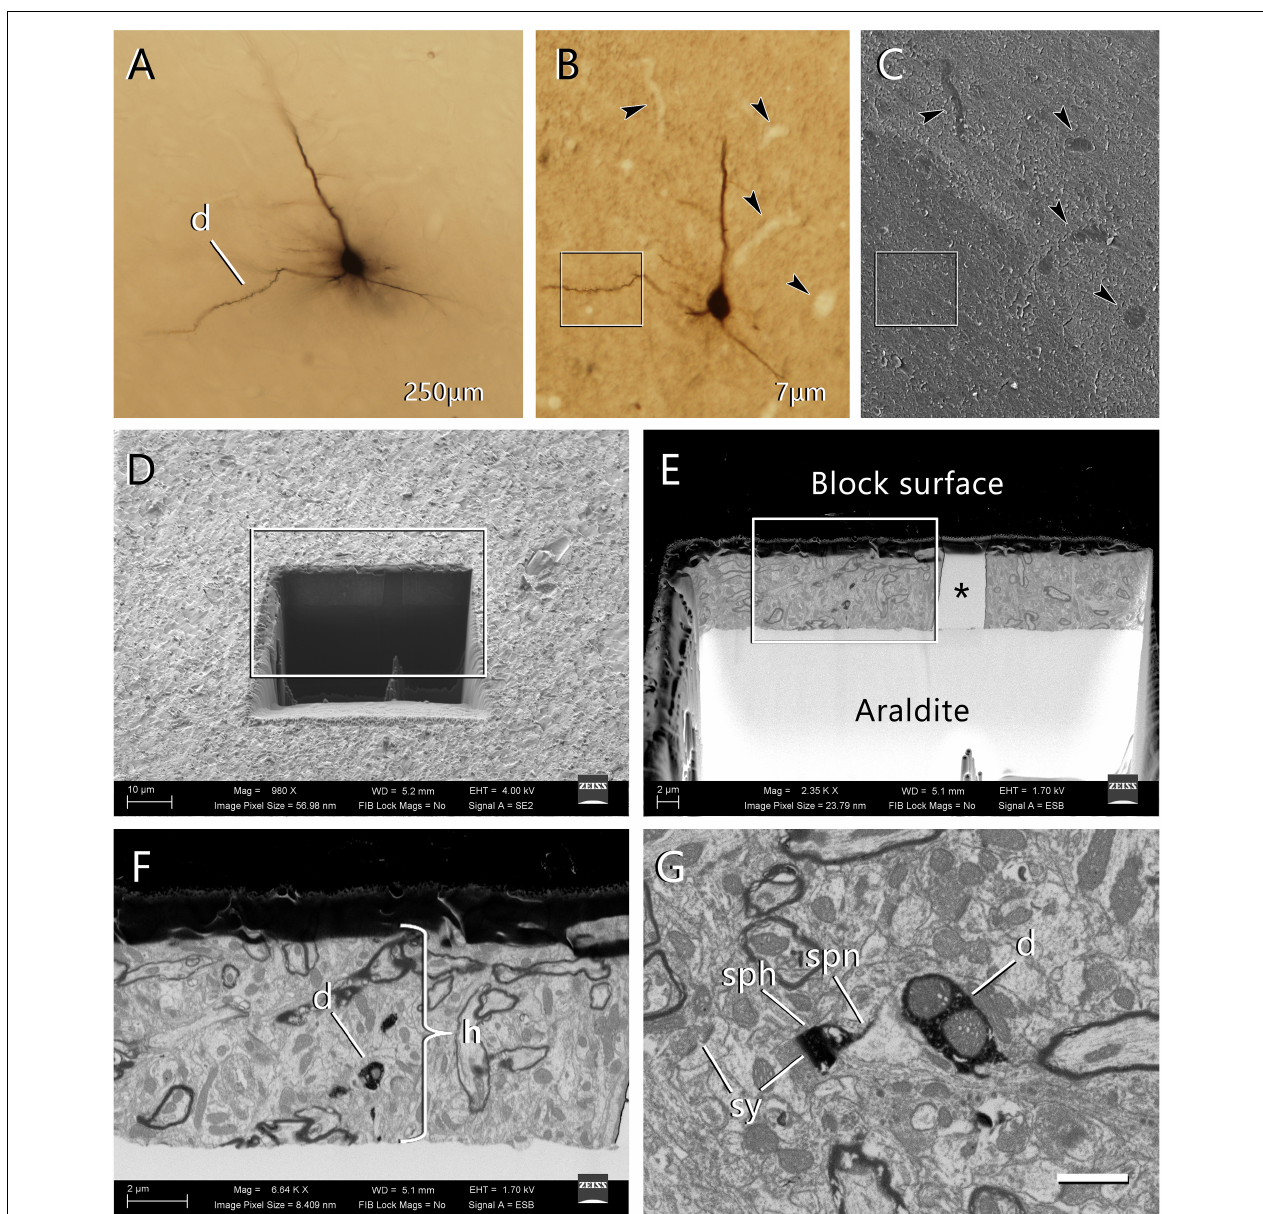
FIGURE 2 | Selection of the region of interest in a labeled cell and FIB-SEM imaging. (A) An intracellularly injected pyramidal neuron in a 250 µ m-thick vibratome section. The labeled cell was injected with HRP, developed with DAB and flat-embedded in Araldite. One dendritic segment (d) was selected for further study. In this particular example, the injected cell was a pyramidal neuron from layer three of the motor cortex. (B) One of the 7 µ m-thick serial sections that were obtained from the 250 µ m-thick vibratome section. This section contains the selected dendritic segment (inset). Blood vessels (arrowheads) were clearly identifiable and were later used as landmarks. Once this section was photographed, it was mounted on a blank Araldite block and observed with the SEM. (C) The surface of the 7 µ m section photographed with the SEM using the secondary electron detector. The same blood vessels were visible (arrowheads), so they were used as landmarks to identify the region where the labeled dendritic segment is located (inset). (D) A viewing trench was excavated with the FIB in the 7 µ m-thick section to gain visual access to the target dendrite. This image was taken with the secondary electron detector. The inset indicates the region that is further magnified in the next panel. (E) Backscattered electron image showing the trench that was excavated with the FIB to identify the selected dendritic segment. The gray scale has been inverted so the block surface appears dark and the Araldite bed appears light. The visible portion of brain tissue is crossed vertically by a blood vessel (asterisk). The region within the inset is further magnified in the next panel. (F) Region of interest where the labeled dendrite (d) is visible due to the dark, electron-dense precipitate. The thickness of the section (h) is approximately 7 µ m. (G) Detail of one of the serial images acquired from the dendrite (d). One of its dendritic spines is visible, showing both the spine head (sph) and spine neck (spn). Synaptic junctions (sy) can be identified on the dendritic spine and in the surrounding tissue. Calibration bar in (G) 50 µ m for (A–C) ; 16 µ m for (D) ; 6.9 µ m for (E) ; 2.4 µ m for (F) ; and 1 µ m for (G)